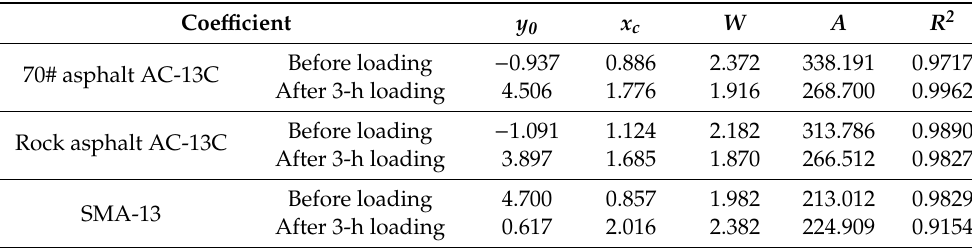
Figure 9. Gaussian fitting curves. ( a ) Before loading; and ( b ) after 3-h loading. Table 10. Coefficients of the Gaussian distribution function.